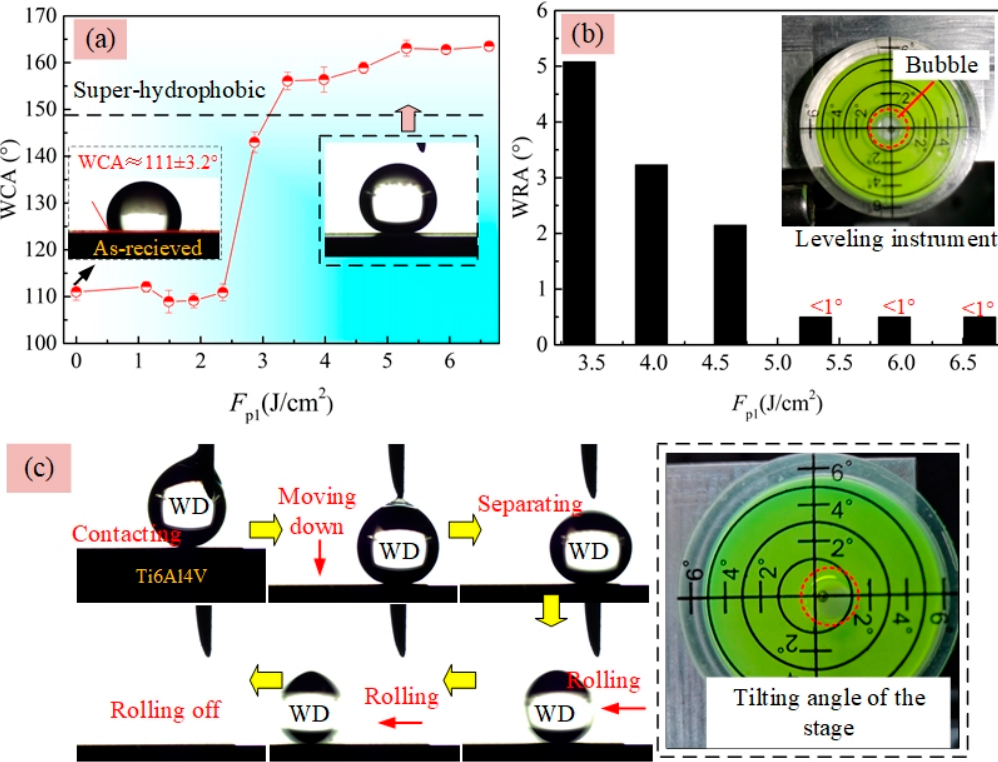
Figure 10. Effect of F p1 on the ( a ) WCA and ( b ) WRA of Ti–6Al–4V surfaces produced by first-step laser irradiation following with silanization; ( c ) sequential photographs of WCA measurement on the superhydrophobic surface obtained at the F p1 of 5.2 J/cm 2 as tilting the stage with small angle of less than 1°.